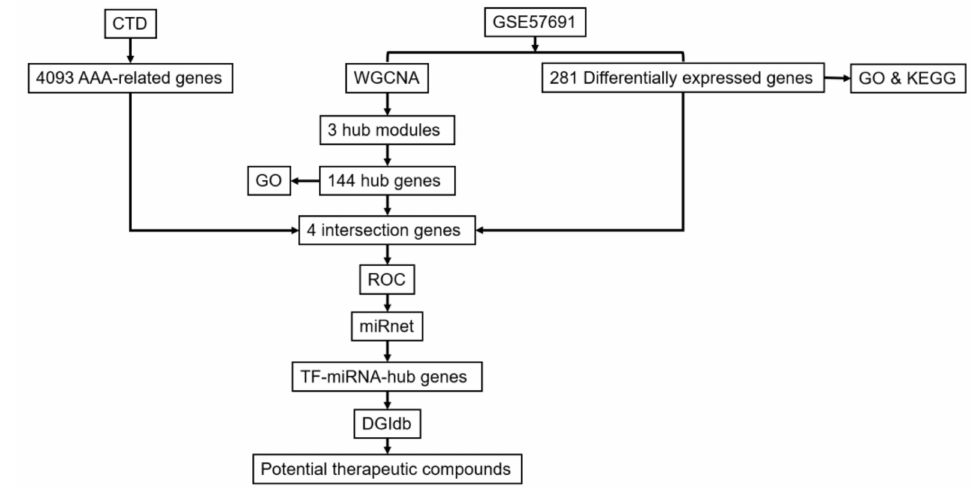
Figure 1. Flowchart of the data